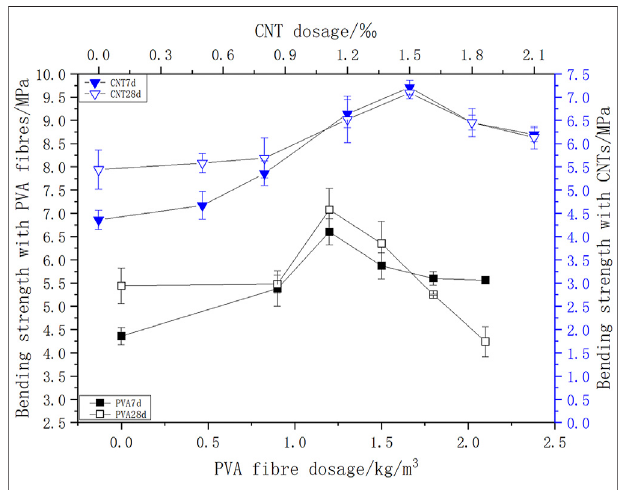
FIGURE 2 | Test result of the compressive strength of strengthened geopolymer with single-doped PVA fi bres or CNTs.